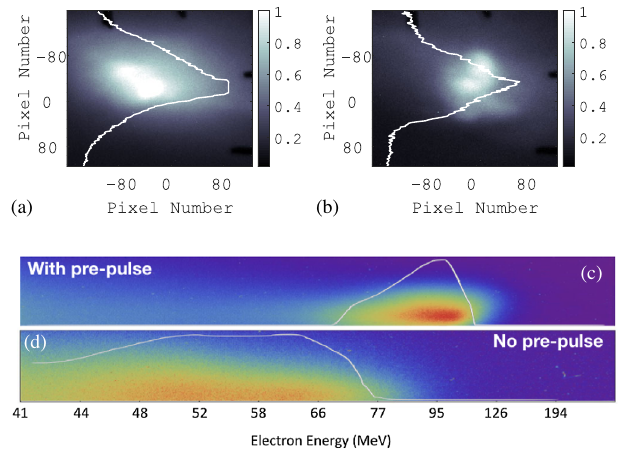
FIG. 1. Electron beam energy deposition on a lanex screen, indicative of beam divergence (a) with prepulse, and (b) without. Note (a) is unfortunately saturated. Lines depict the relative signal and show both increased total signal (charge) and reduced divergence. Representative electron spectra with prepulse (c) and without (d). Spectra are imaged in the vertical direction corroborating (a) and